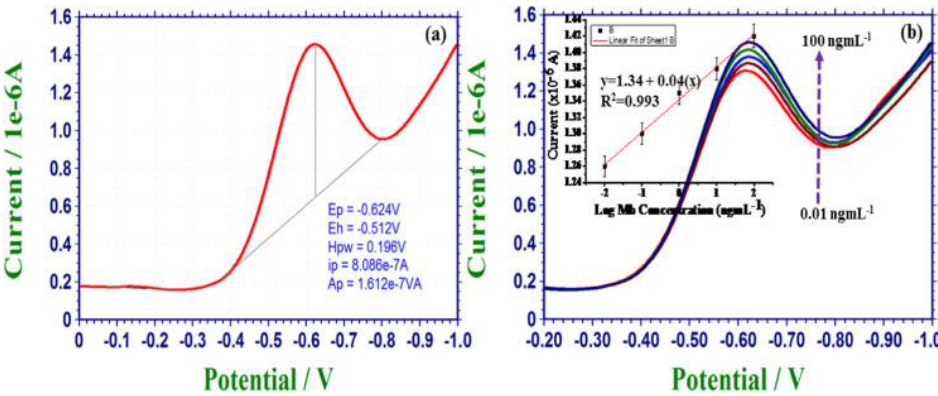
Figure 4. ( a ) DPV results for Ab/GQD/electrode-based electrochemical sensor in the presence of myoglobin and ( b ) DPV measurements as a function of myoglobin concentration; inset linearity graph. Reprinted with permission from reference [46], copyright 2016 Elsevier.